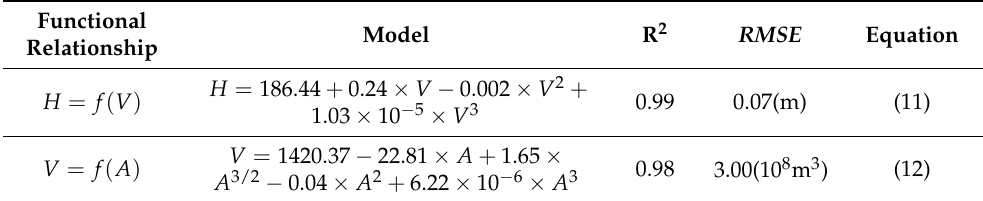
Figure 10. Prediction of lake area based on inflow. 3322 15.13430055.41737087118.830931.401512 29.6105206.216478 QQQQQ QA ++−−+×+−=